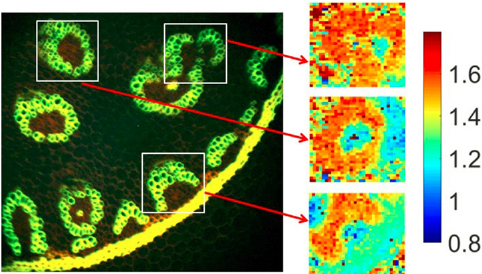
Fig. 4. Example results from a wide-¯eld FLIM system using a 32 (cid:1) 32-pixel SPAD array with internal TDCs. Left panel: In- tensity image of a wide ¯eld of view, acquired by a normal CCD camera. Right panel: 32 (cid:1) 32-pixel FLIM images of the three marked ROIs by the SPAD array. Reprinted with permission from Ref. 63, OSA